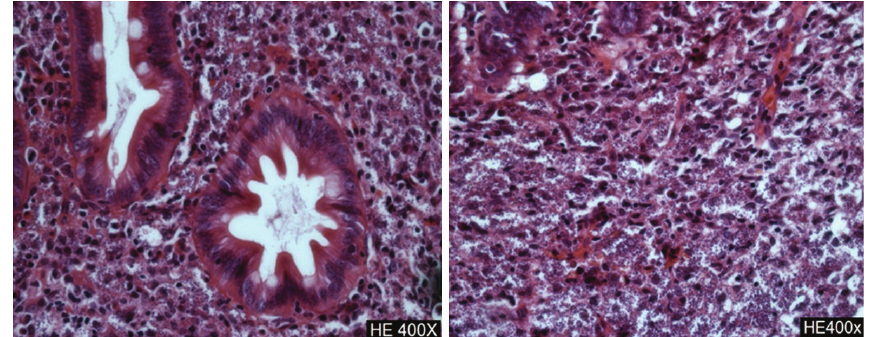
Figure 1: Histological analysis of the duodenum showing extensive infiltration with Leishmania bodies (hematoxylin and eosin, × 400).